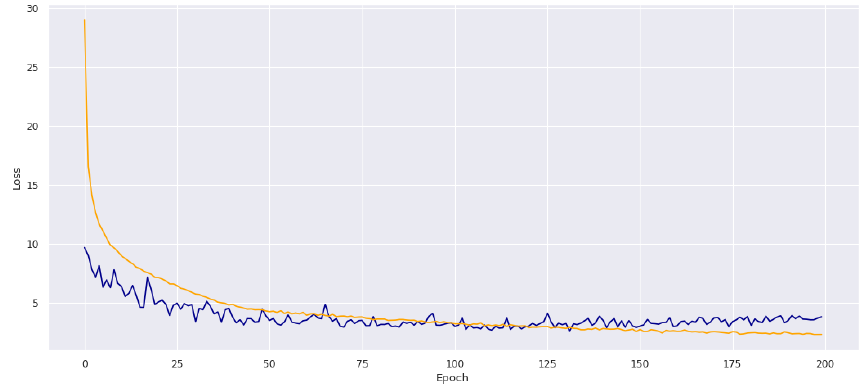
Figure 10. Results of contact area prediction through MLP training.